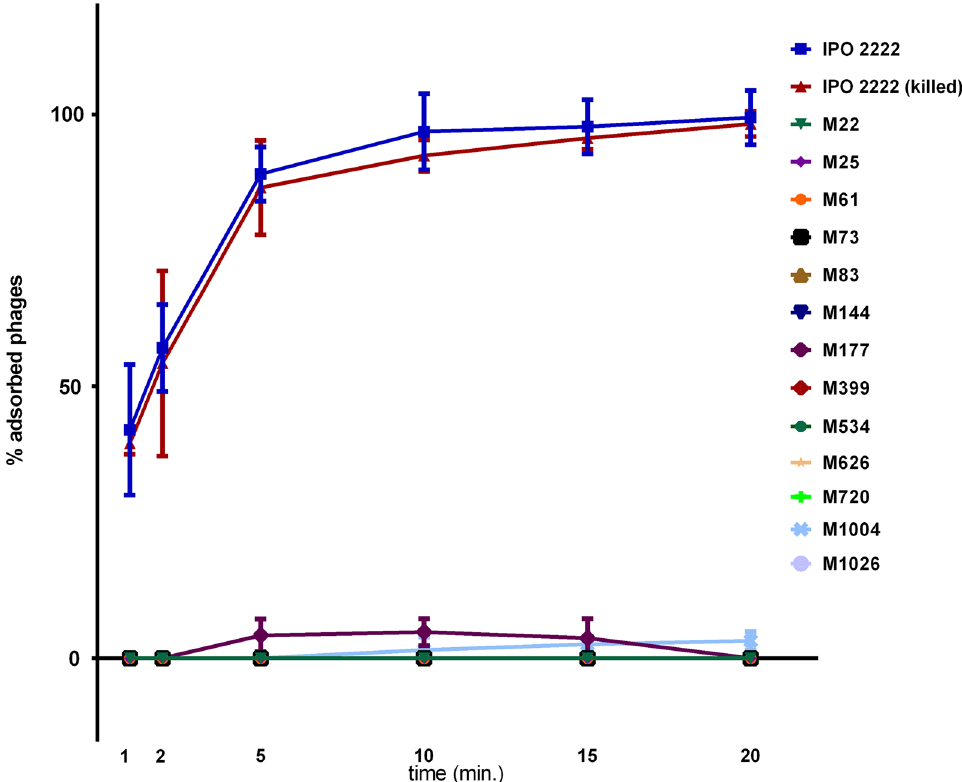
Figure 2. Adsorption of ΦD5 to viable and chloramphenicol-killed cells of WT and phage-resistant D. solani . A MOI of 0.01 of ΦD5 was used for adsorption assay and the total assay time was 20 min. Phage adsorption was calculated as follows: the percentage adsorption = (the average titer of unabsorbed phages per sample/average titer of phages in negative control) × 100. The averages and standard deviations of three independent repetitions per strain (WT or mutants) are